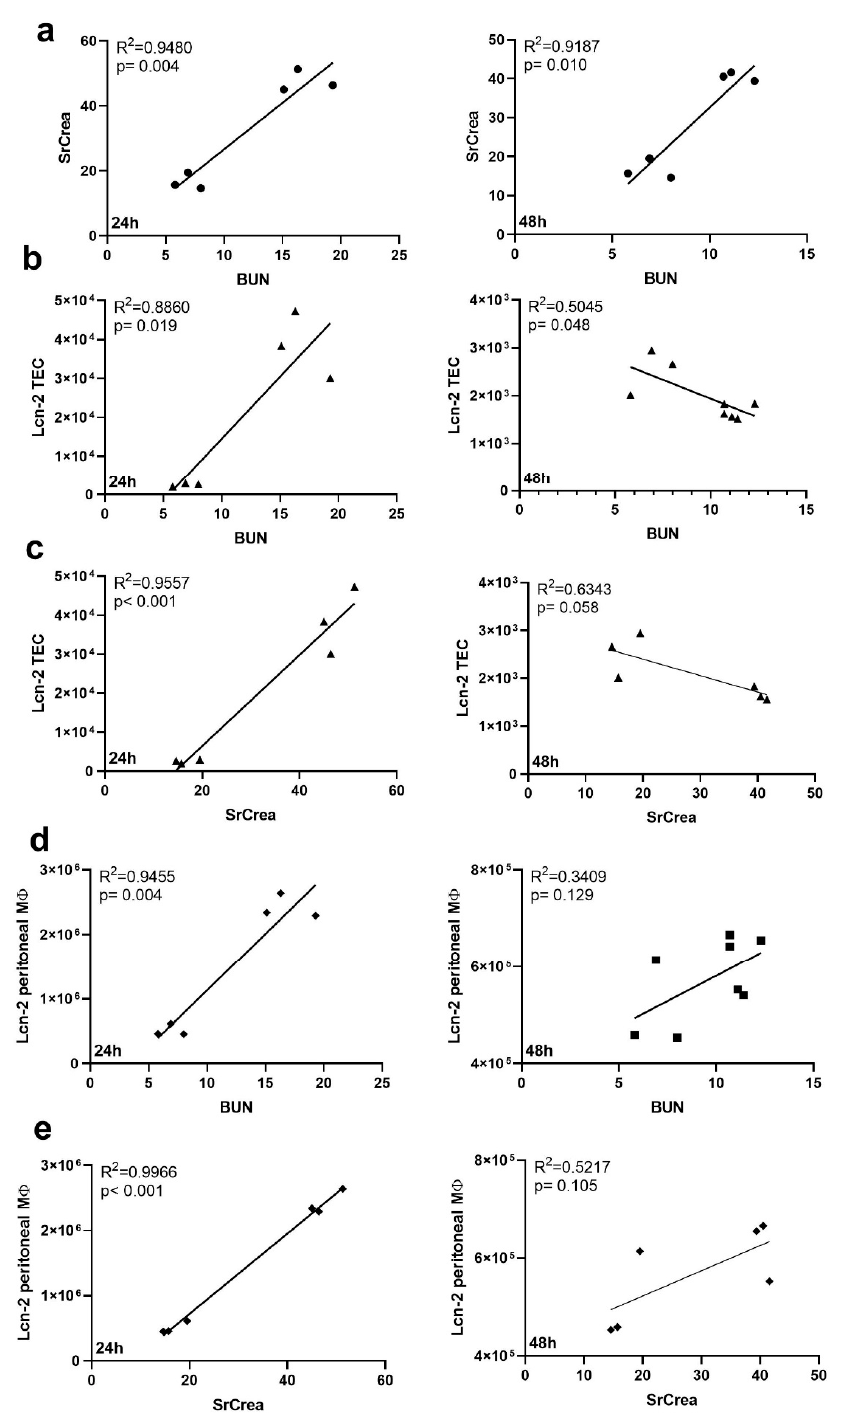
Figure 3. Renal injury markers correlate with Lcn-2 from TEC and peritoneal M Φ during sepsis. ( a – e ) Correlation between injury markers BUN ( a , b , d ) and SrCrea ( c , e ) with ( a ) each other or ( b , c ) Lcn-2 protein expression in TEC, or ( d , e ) with Lcn-2 expression from peritoneal M Φ (separated by time points after CLP treatment, 24 h and 48 h respectively). Both R 2 and the p -value for each correlation are indicated in the individual